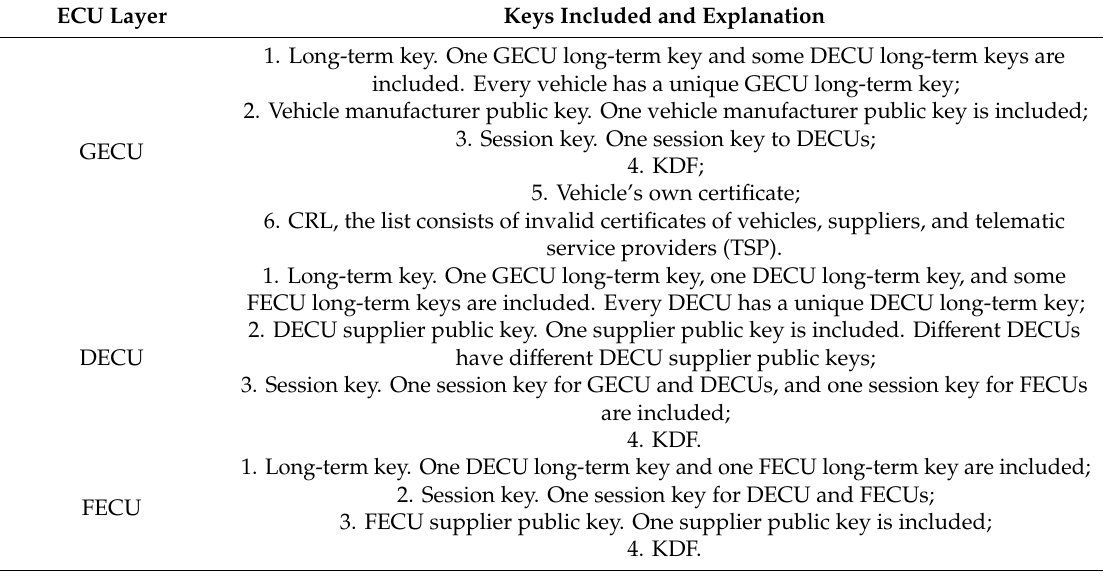
Table 3. Keys and functions included in the ECUs of each layer.